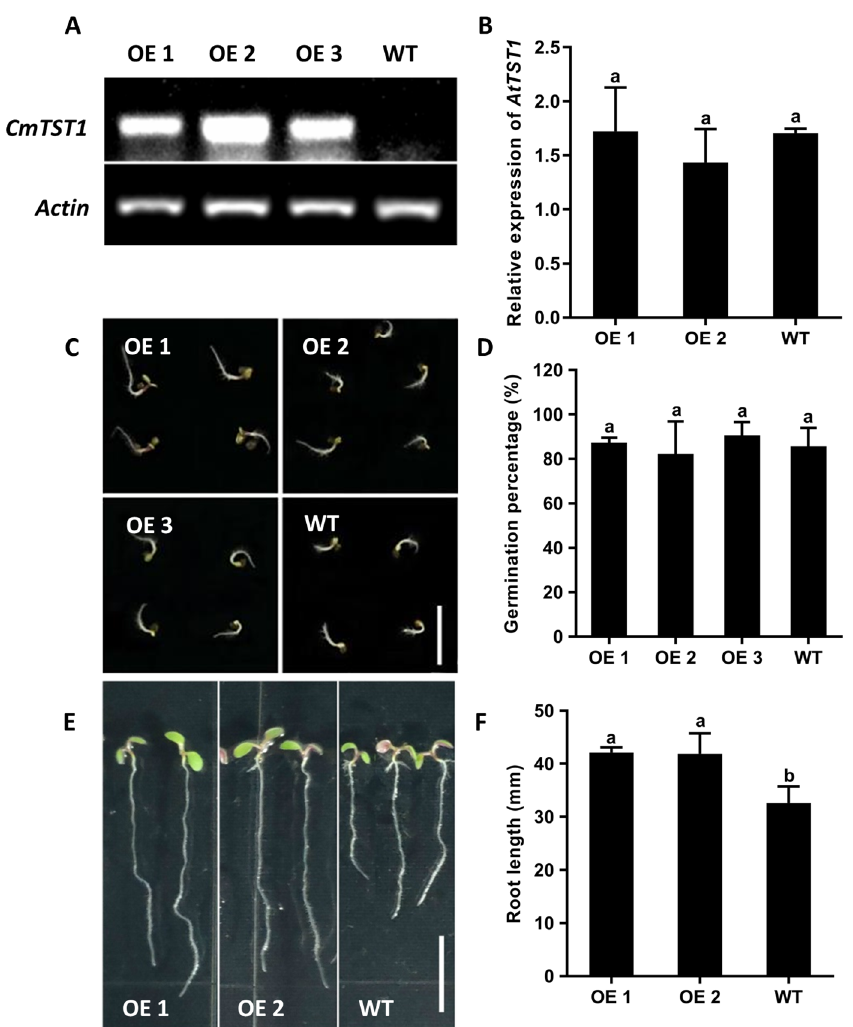
Figure 4. Overexpression of CmTST1 in Arabidopsis seedlings (OE) improved the root growth under a high sucrose level (6%, w/v ) condition. (A) Semi-quantitative PCR analysis of the expression of CmTST1 in the wild type (WT) and transgenic Arabidopsis lines (OE 1, OE 2, and OE 3). (B) Comparison of the relative expression of AtTST1 in OE lines and the WT. (C) Phenotype of 3-day-old seedlings grown in 6% Suc. (D) Germination percentage of OE and WT Arabidopsis seeds. (E) Seedlings of OE and WT after growing on 6% Suc for 9 days. (F) Average root length of seedlings after growing on 6% Suc for 9 days. WT, wild type. Bar = 5 mm. Results represent at least three biological replications. Lowercased letters above the bar indicate that significant differences between the OE seedlings and the WT were assessed by one-sided paired t -tests ( p < 0.05).